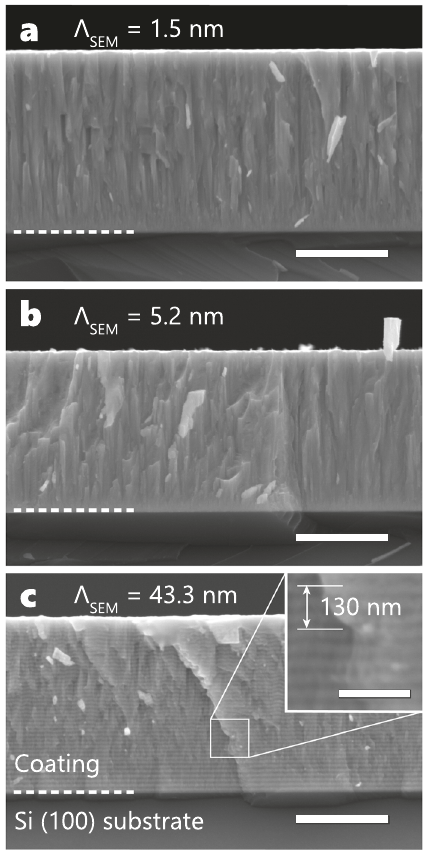
cross sections of our MoN – TaN coatings with nominal bilayer periods of 1.5, 5.2, and 43.3 nm, respectively. The dashed lines sign the interface between the coating and Si (100) substrate. The inset in ( c ) shows an enlarged view visualizing the layered structure of this coating. The scale bars in ( a ) to ( c ) are 1 µ m, the scale bar in the inset has a length of 200